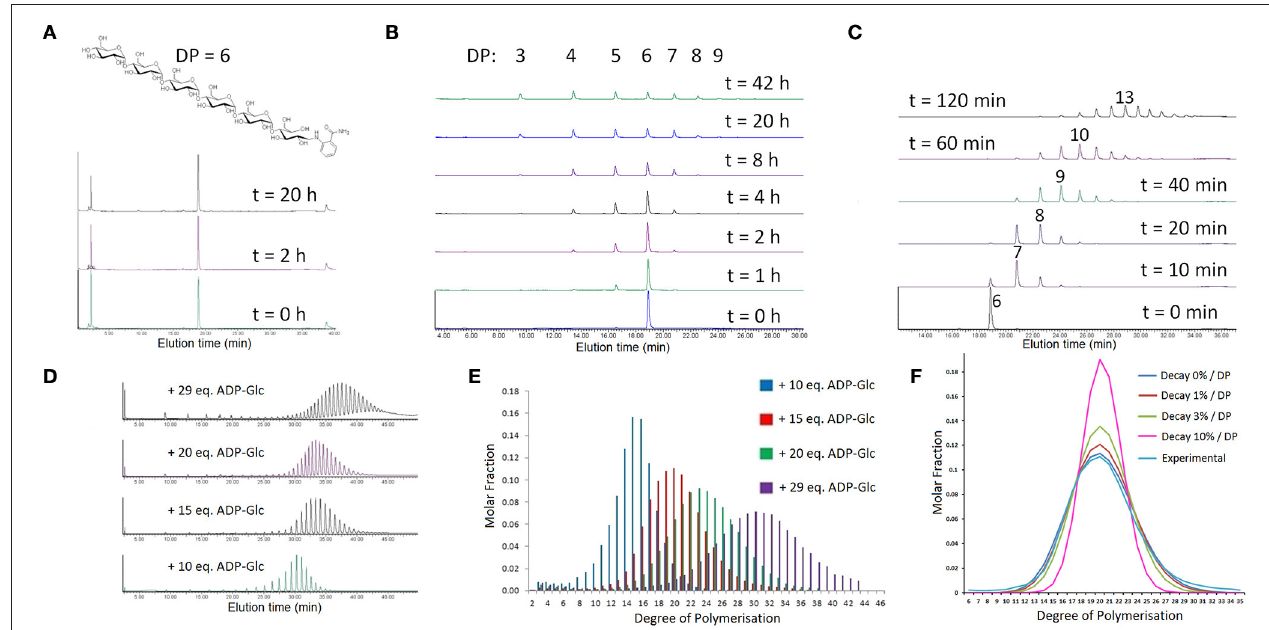
FIGURE 2 | Reversibility and long-range elongation profile of SSI. (A) Structure of the fluorescently labeled acceptor and proof of the absence of any reaction in the absence of both ADP and ADP-Glc, but in the presence of enzyme and fluorescent acceptor. (B) UPLC reaction profile over time after addition of 10mM ADP. (C) UPLC reaction profile over time after addition of 5mM ADP-Glc. (D) UPLC reaction profiles with a truncated version of Hv SSI after addition of variable amounts of ADP-Glc, measured after all donor was depleted. Only for panels (D–F) in this figure are the data originating from the truncated version of Hv SSI. (E) Molar fraction of each MOS species after integration of peak areas from panel (D) . (F) Models of expected MOS species distributions with different kinetic models, compared with the molar fractions from panel e (“Experimental” corresponds to the red bars in panel E